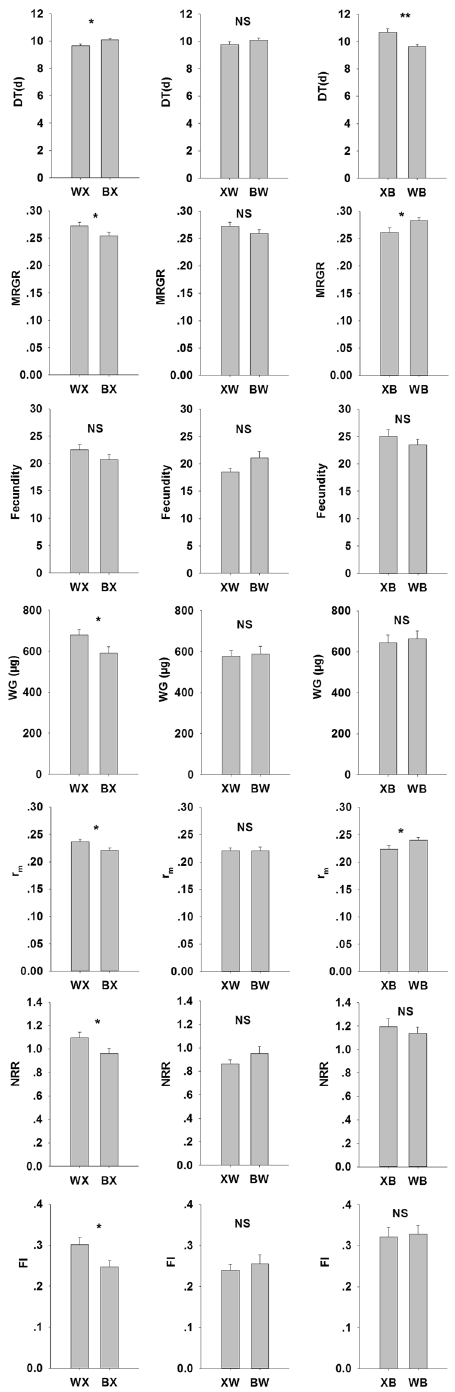
Figure 4. The life-history trait values of different population offspring aphids on same transition